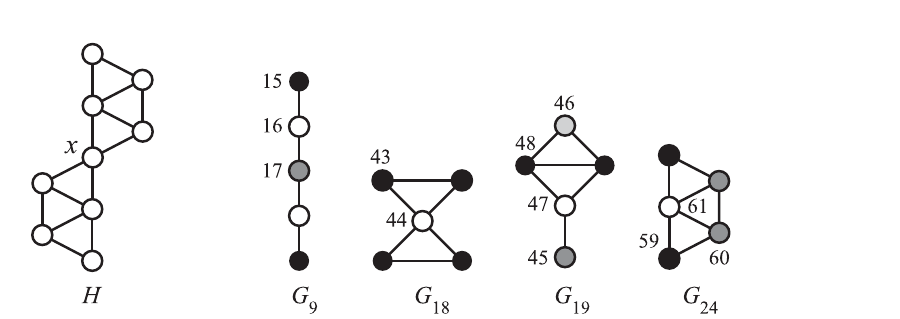
. Graphs and orbits are numbered as in 5